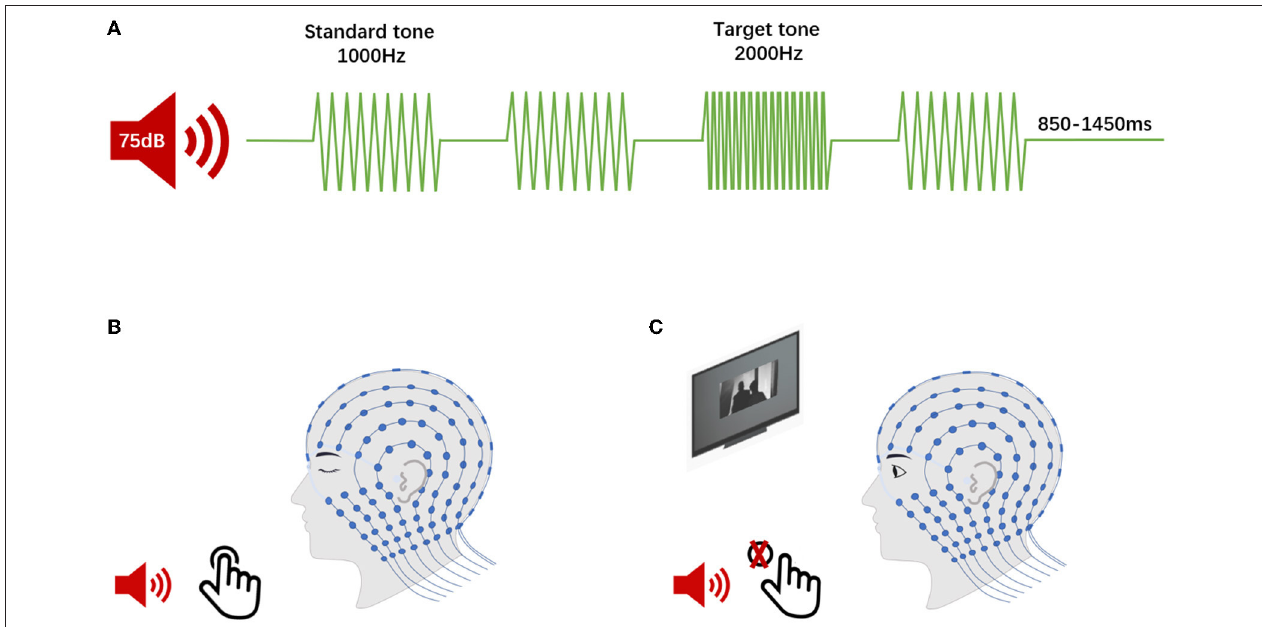
FIGURE 2 | Event-related potentials (ERPs) procedure. (A) The continuous auditory stimulus comprised both rarely presented target sounds and frequently presented standard sounds in two tasks. (B) The 2-tone auditory oddball task (P300, for top-down analyses). The participants were required to discriminate the target stimulus from the standard tone by pressing a button. (C) The passive listening task (MMN, for bottom-up analysis). The participants were instructed to watch the silent movie without responding to the presented auditory